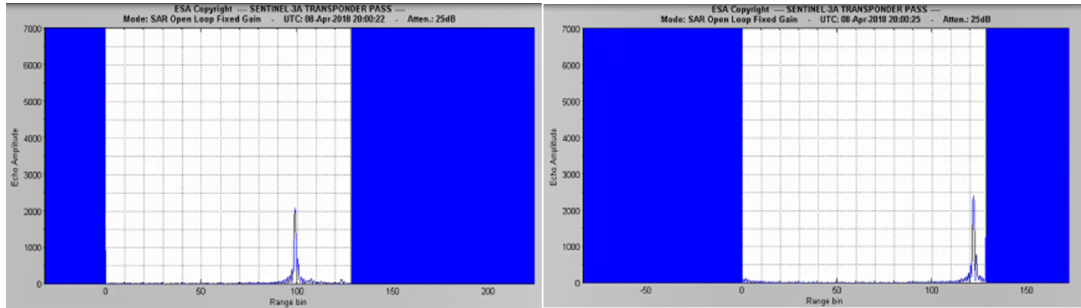
Figure 10. Screenshots of the transponder response movie for the Sentinel-3 Pass No.14 calibration on 8 April 2018. The transponder echo in the altimeters records as it enters ( left ), reaches its maximum ( middle ) and leaving ( right ) the tracking window. Similar echo movies are generated within 24 h after each satellite overpassed the CDN1 transponder Cal/Val site.